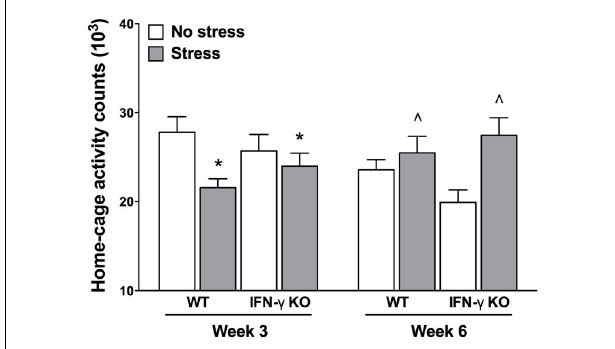
FIGURE 2 | Influence of chronic stress on home-cage locomotor activity among IFN- γ wild-type and knockout mice. Overall, chronic stressor exposure had the effect of reducing home-cage activity atWeek 3 (mid-way through the experiment), but increasing locomotor activity at Week 6 (end of experiment). However, the early occurring hypolocomotive effect of stress was clearly most prominent in theWT animals, whereas the stressor’s later-occurring hyperlocomotive effect was most evident in the KO mice (see accompanying text). Data are presented as mean ± SEM. * p < 0.05 relative to non-stressed mice (collapsed across genotype) at Week 3, and ˆ p < 0.05 relative to non-stressed mice (collapsed across genotype) atWeek 6 (Two-way repeated measures ANOVA).WT, wild-type; KO,